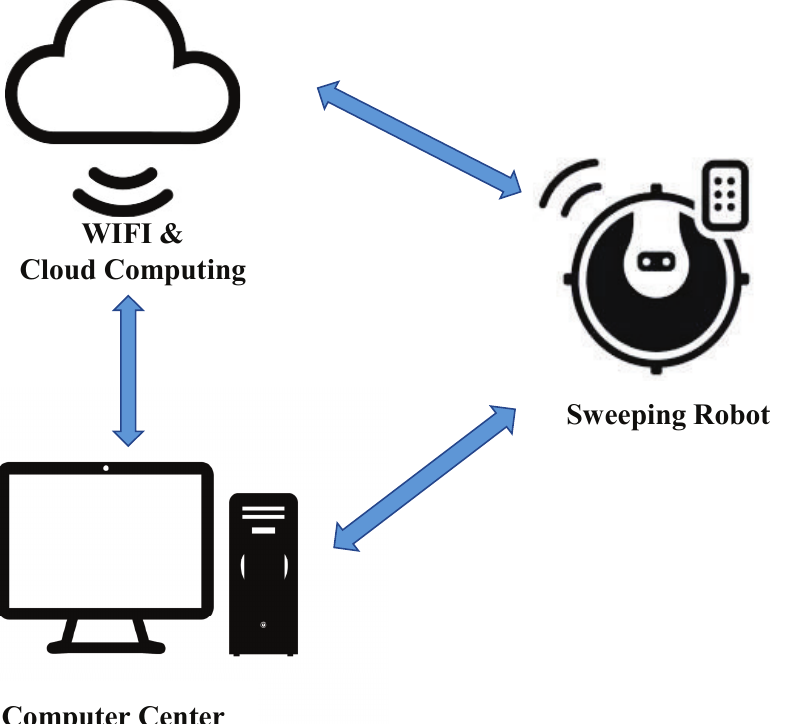
Figure 1. Sweeping robot using cloud